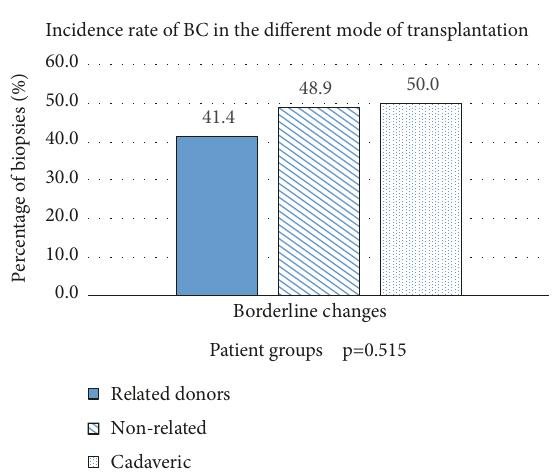
Figure 4: The proportion of HLA-DR antigen mismatches in BC.